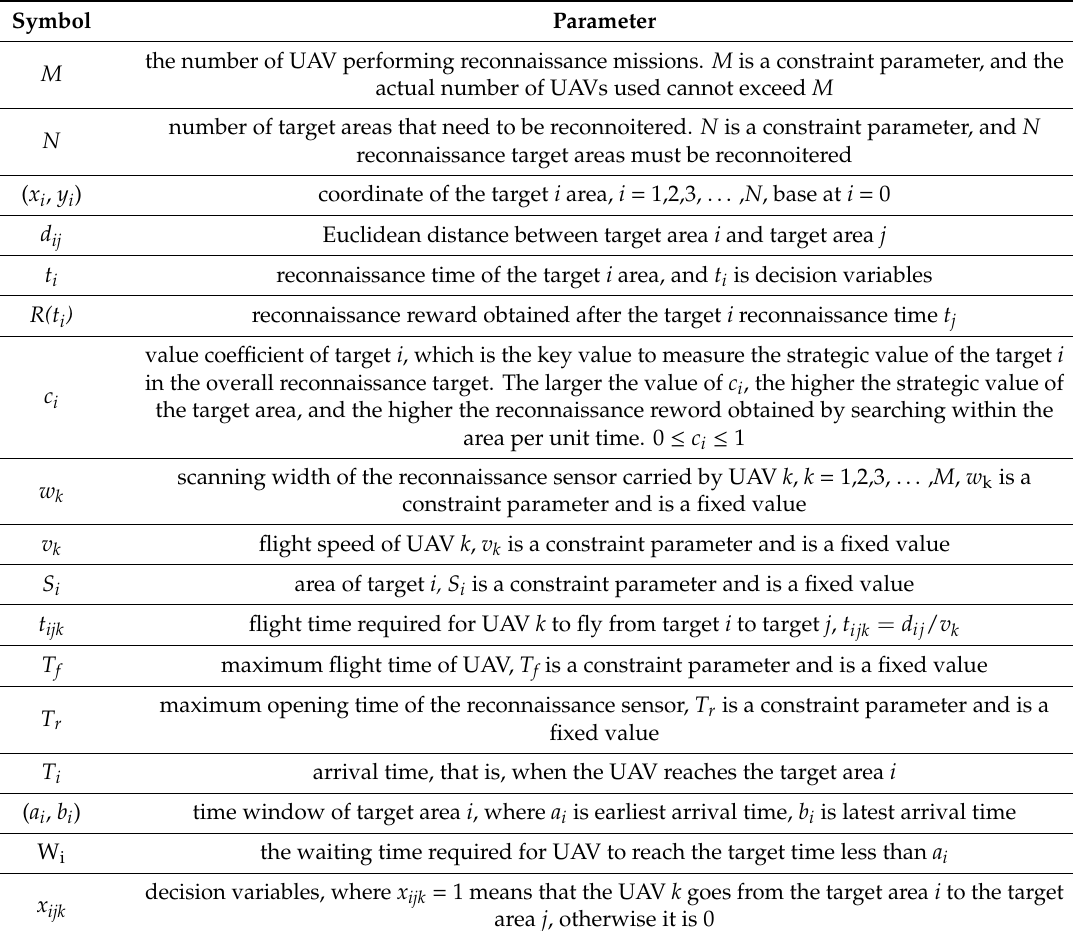
Table A1. Symbols and